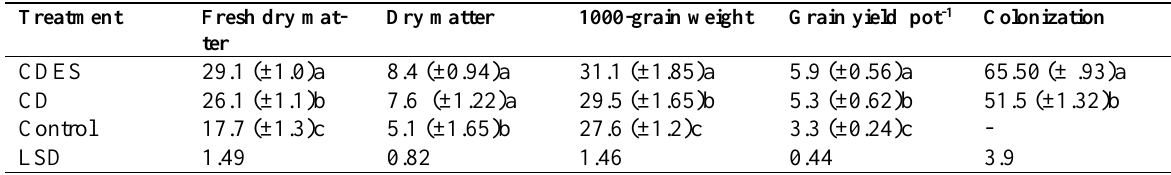
Table 3 Agronomic traits and colonization percentage of S. indica of wheat in response to application of cow dung vermicompost (CD) and cow dung + eggshell vermicompost (CDES) Treatment Fresh dry